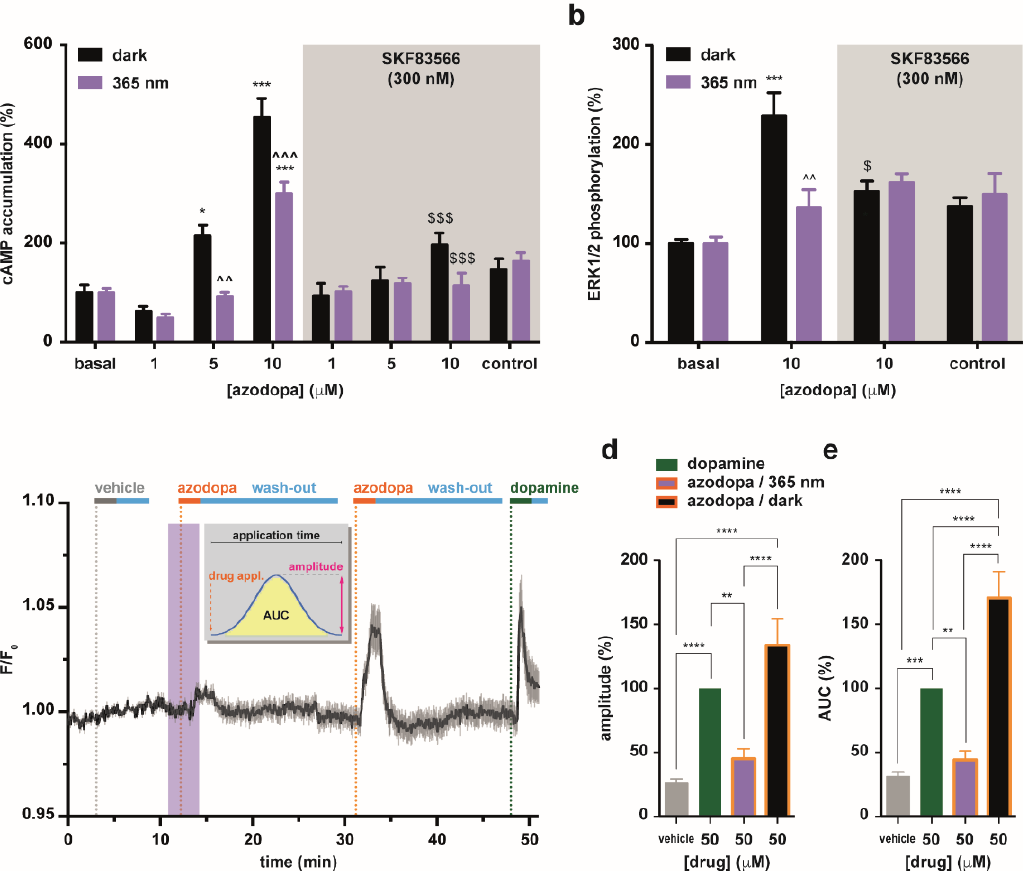
Figure 2. In vitro pharmacological characterization of azodopa. ( a ) Effect on D 1 -mediated adenylyl cyclase activation. cAMP accumulation experiments in HEK-293T cells transiently transfected with D 1 and treated with different concentrations of azodopa, in the dark (black bars) or under illumination (purple bars), in the presence (gray area) or not (white area) of a D 1 -like receptor antagonist (SKF83566). Values are represented in percentage vs. basal levels of cAMP. Data are mean ± S.E.M. (6 experiments performed in quadruplicate). Statistical differences were analyzed by two-way ANOVA followed by Tukey’s post hoc test (*** p < 0.001 vs. basal; * p < 0.05 vs. basal; ^^^ p < 0.001 vs. dark; ^^ p < 0.01 vs. dark; $$$ p < 0.001 vs. controls non-pretreated with the antagonist). ( b ) Effect on D 1 -mediated ERK1/2 activation. ERK1/2 phosphorylation was determined in HEK-293T cells transiently transfected with D 1 and treated with different concentrations of azodopa, in the dark (black bars) or under illumination (purple bars), in the presence (gray area) or not (white area) of a D 1 -like antagonist (SKF83566). Values are represented in percentage vs. basal levels of ERK1/2 phosphorylation. Data are mean ± S.E.M. (3 or 4 experiments performed in triplicate or quadruplicate). Statistical differences were analyzed by two- way ANOVA followed by Tukey’s post hoc test (*** p < 0.001 vs. basal; ^^ p < 0.01 vs. dark; $ p < 0.05 vs. controls non-pretreated with the antagonist). ( c – e ) Effect on D 1 -mediated intracellular calcium release compared to dopamine. ( c ) Real-time calcium imaging response (averaged traces, black line, n = 24 cells) in HEK-293T cells co-expressing D 1 receptors and R-GECO1 as calcium indicator. Traces were recorded upon direct application of azodopa (50 µM, orange bars) in the dark (white area) and under illumination (purple area). Shadow represents “ ± S.E.M. ” . Gray and green bars indicate the application of vehicle (control) and dopa- mine (reference agonist), respectively. Light blue bars indicate wash-out periods. See example